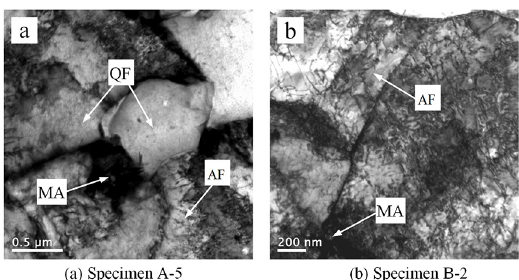
Figure 8. TEM micrographs of specimens showing the presence of MA island.